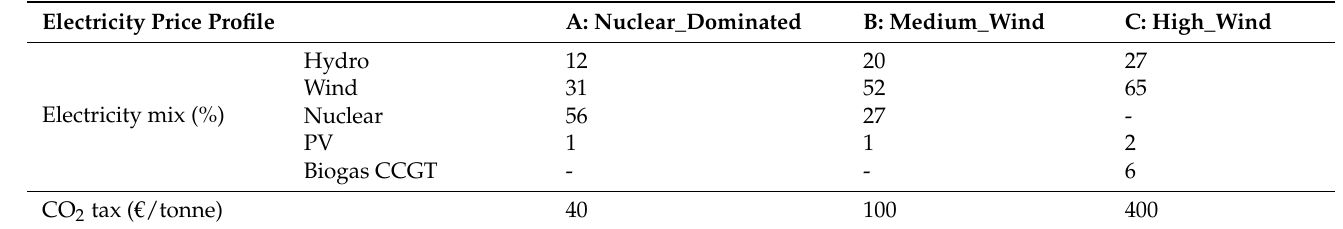
Figure 6. Amount of dispatchable heat production over the year assumed to be generated at the reference DH plant. Table 1. Electricity mixes and cost of CO 2 tax for the three electricity price profiles considered. Notes: CCGT, combined cycle gas turbine; PV, photovoltaic.